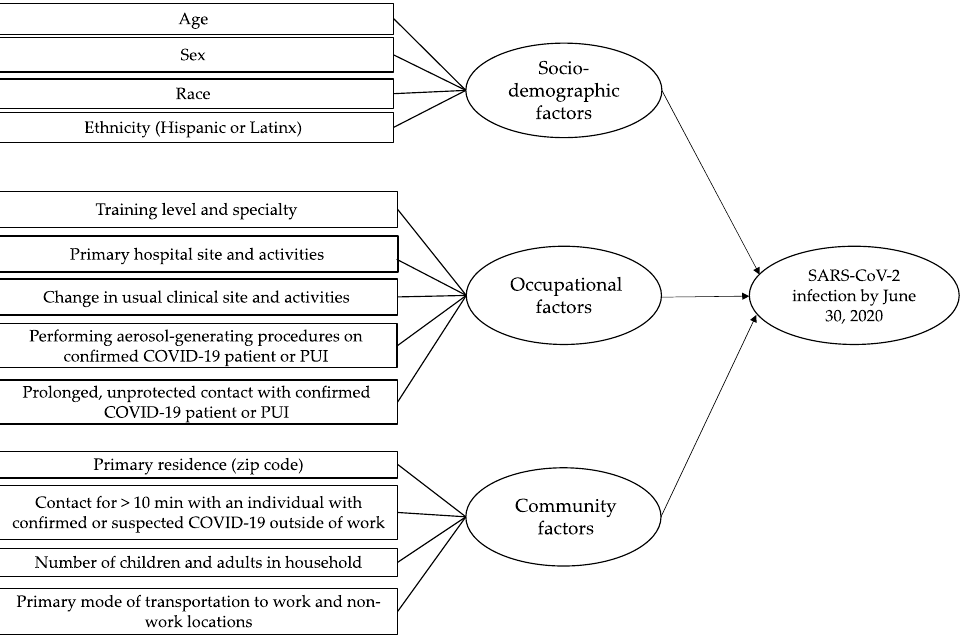
Figure 2. Risk factors hypothesized to be associated with SARS-CoV-2 infection in physician trainees.